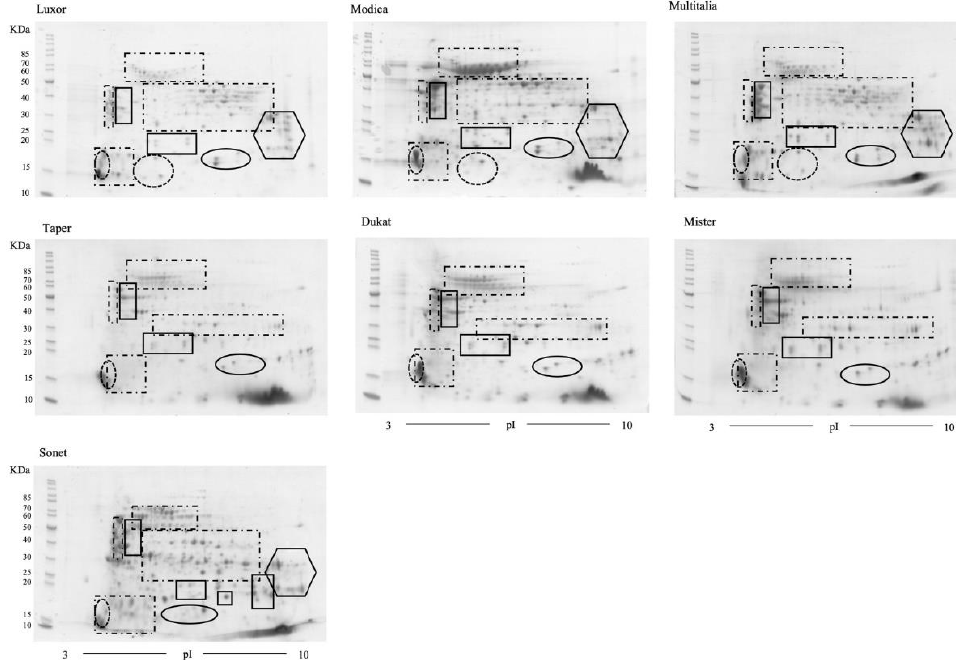
Figure 2. 2D gels of three different cultivars of Lupinus. albus (upper gels), L. luteus (middle gels), and L. angustifolius (lower gel). Standard markers are indicated (in kDa) on the left side. Solid-line rectangles indicate the acidic and basic subunits of α -conglutin/legumin. Dash-and-dot rectangles indicate β - conglutin/vicilin. The dotted ovals indicate δ -conglutin. The solid-line ovals enclose the large and small subunits of γ -conglutin. The solid-line hexagons enclose the subunits of both β - conglutin and γ -conglutin.